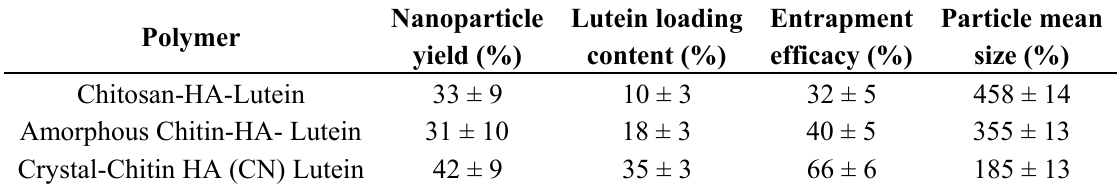
Table 1. Nanoparticles yield, Lutein loading content and entrapment efficiency of different kind of chitin and chitosan complexed with hyaluronic acid.